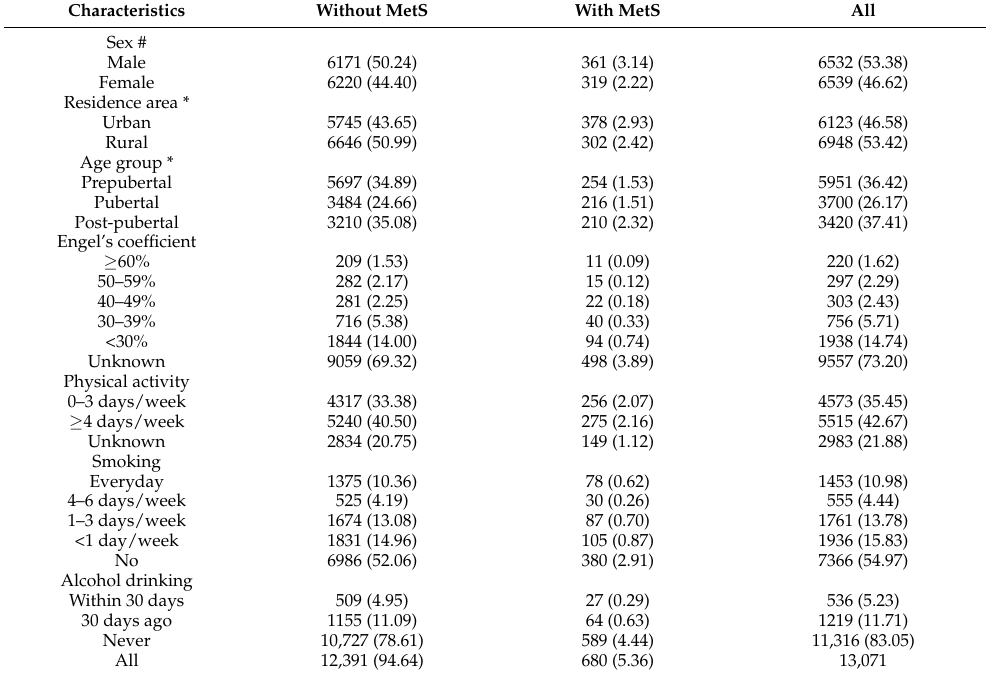
Table 1. Weighted general characteristics [ n (%)] of children and adolescents in 2016–2017 by MetS